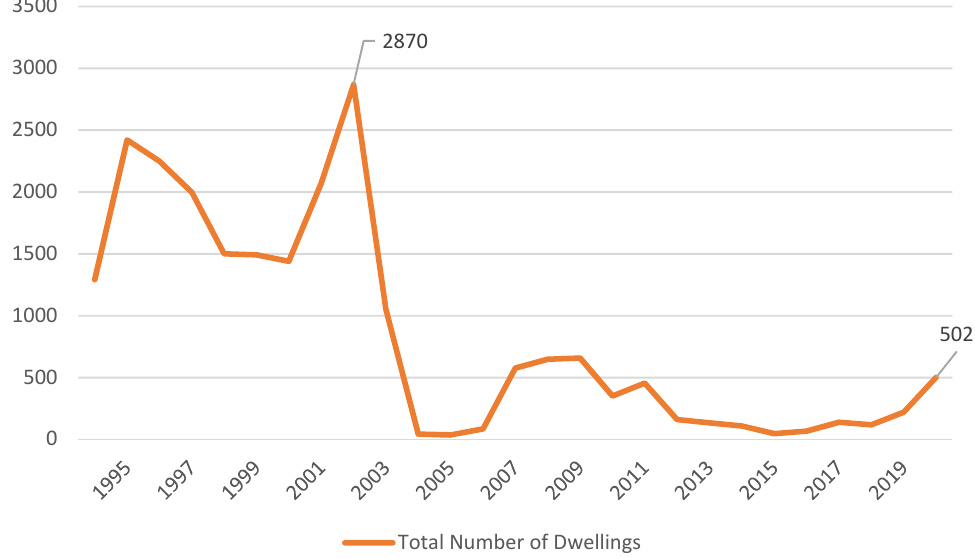
Figure 2. Total number of completed dwellings in new constructions for family housing in Lisbon. Source: INE.